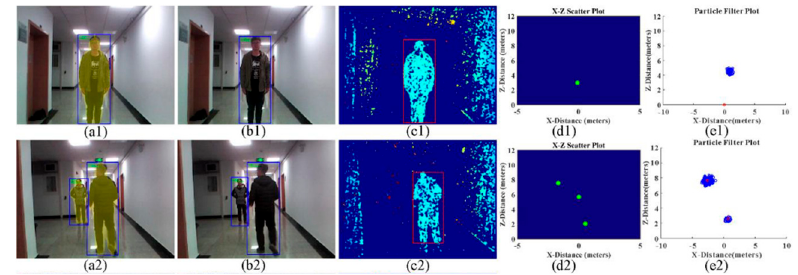
Figure 10. Tests performed in an indoor environment and related results [24]. ( a1 , a2 ) Detection performed by R-CNN, ( b1 , b2 ) detection performed by SSD network, ( c1 , c2 ) image results, ( d1 , d2 ) data detected by the radar, ( e1 , e2 ), data fused using a particle filter.